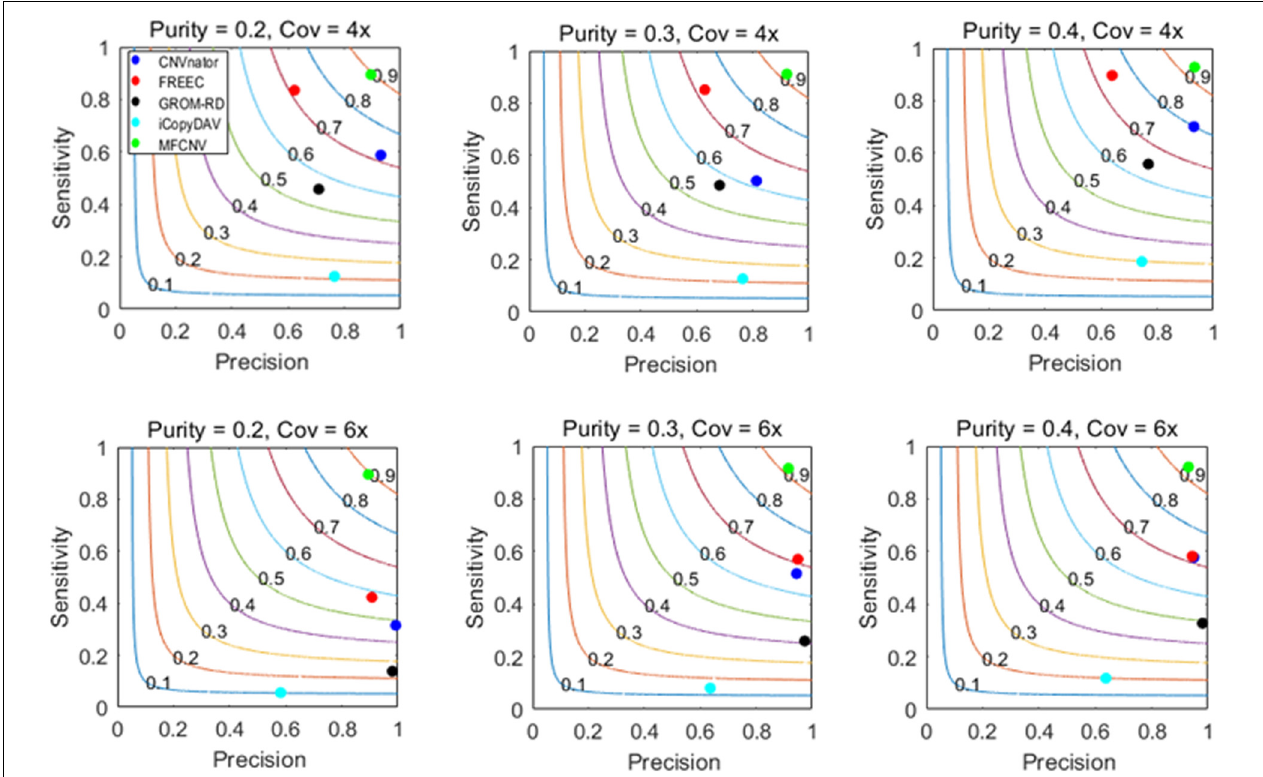
FIGURE 3 | Performance comparisons between our proposed method and the four peer methods in terms of sensitivity, precision, and F1-score (colored curves) on simulation datasets.